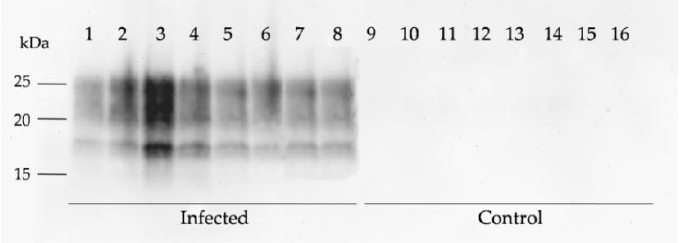
Figure 5. Western blot detection of PrP res accumulation in the CNS of clinically affected tg338 mice intracerebrally inoculated with scrapie compared with matched controls. Equivalent protein quantities were loaded for adequate comparison and immunoblots were run using SHA31 monoclonal antibody. Molecular-weight markers (kDa) are indicated on the left side of the immunoblot.